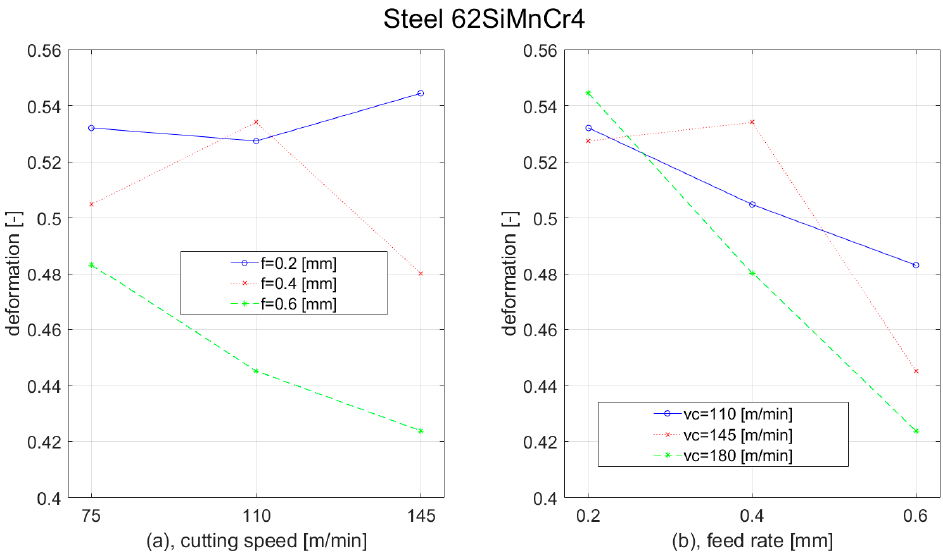
Figure 11. Graph of deformation dependence of Steel 62SiMnCr4 on: ( a ) cutting speed; ( b ) feed rate.